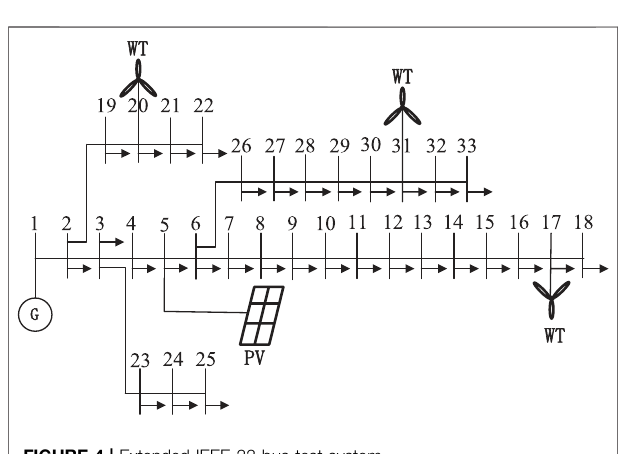
FIGURE 4 | Extended IEEE-33 bus test system.